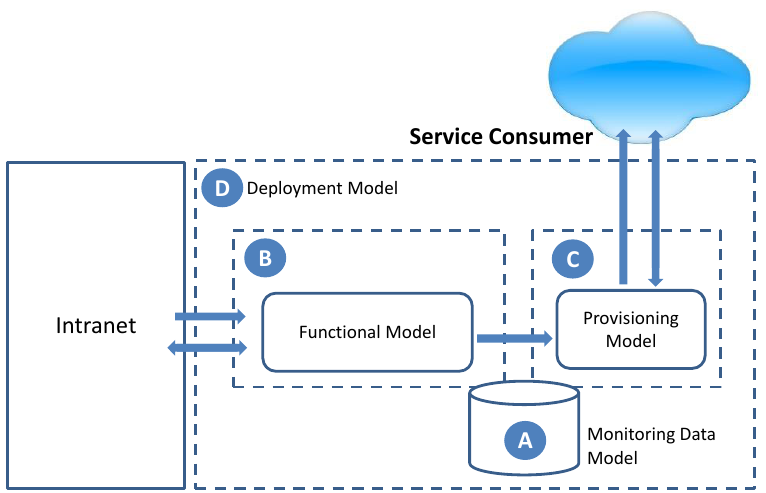
Figure 2. General scenario for the proposal of a smart monitoring model for saving energy in data centers.